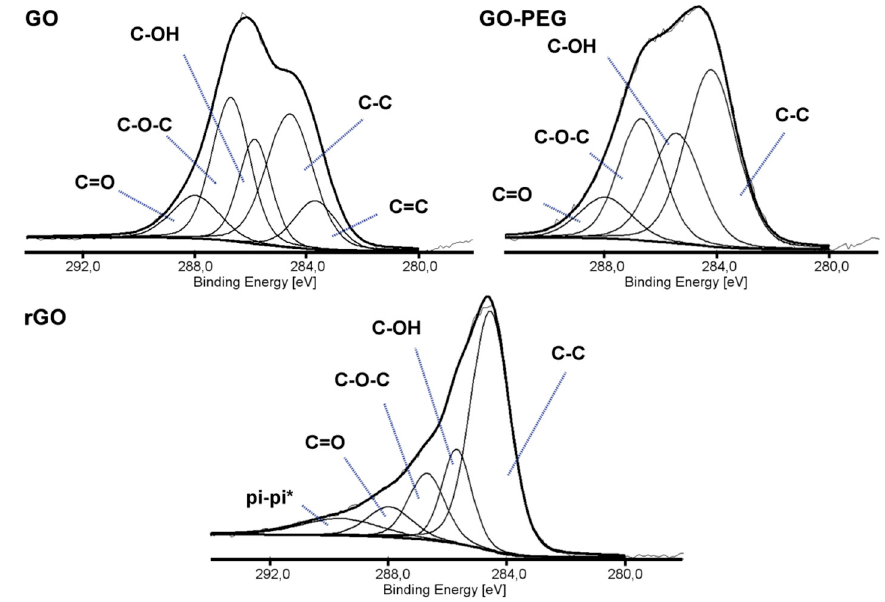
Figure 1. X-ray photoelectron spectroscopy (XPS) spectra (C1s) of graphene oxide (GO), poly(ethylene glycol) grafted graphene oxide (GO-PEG) and reduced graphene oxide (rGO).